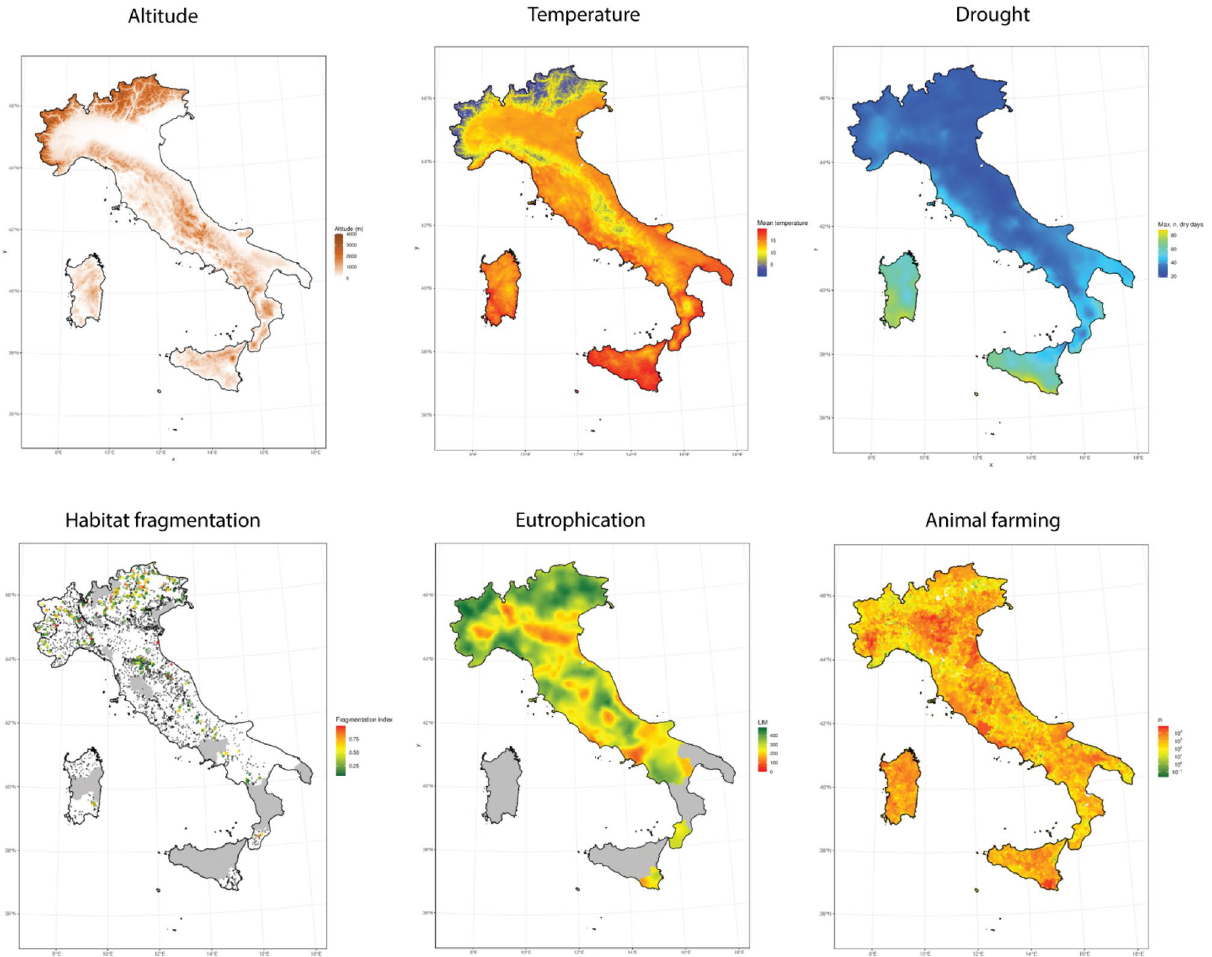
Figure 2. Spatial distribution of the most relevant drivers of invasion, analyzed in this study. From left to right, and top to bottom, altitude, temperature, drought period, habitat fragmentation, eutrophication and animal farming. See Supplementary Fig. 1 for the distribution of the other main drivers analyzed. This figure was created with R 31 .